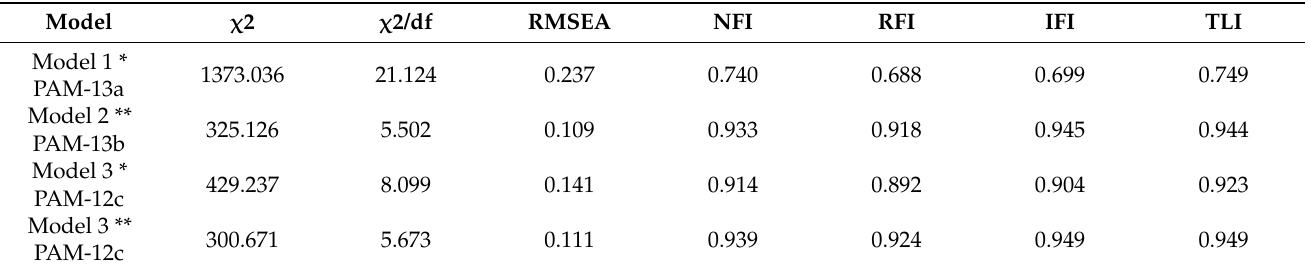
Table 3. Result of CFA for PAM